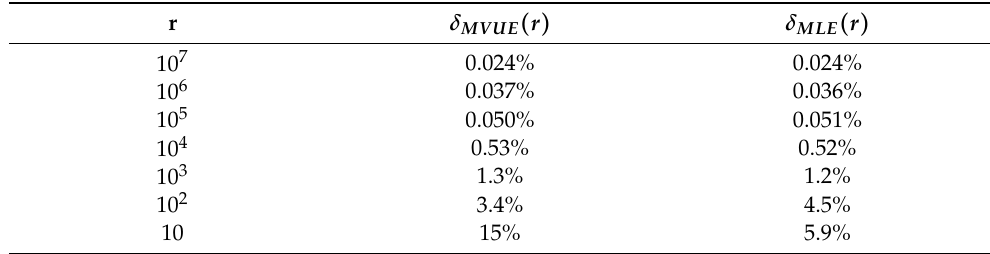
Table 1. The percent errors of the rate parameter estimation. The results are rounded to two significant figures. The estimators ˆ λ MVUE ( r ) (10) and ˆ λ MLE ( r ) (12) were